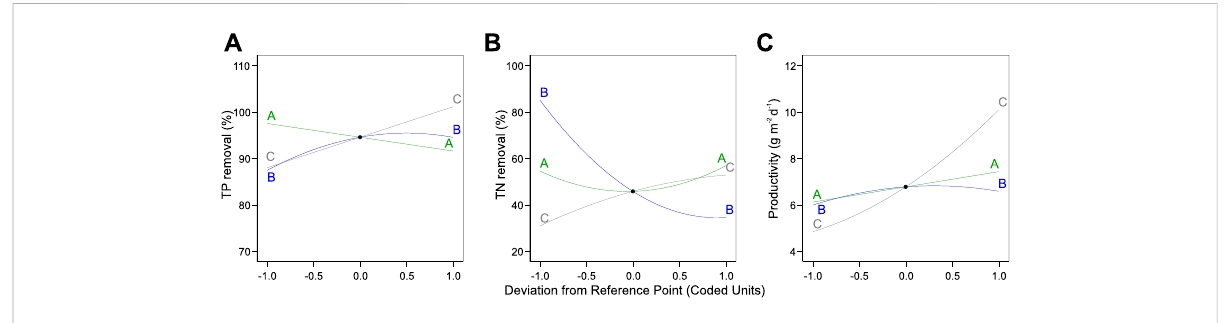
(Figure 5B), as con fi rmed by the linear model coef fi cients.